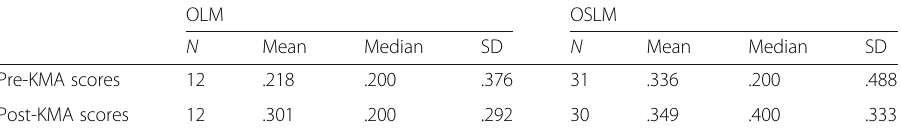
Table 7 KMA mean, median, and standard deviation scores for the OLM and OSLM groups OLM OSLM N Mean Median SD N Mean Median SD Pre-KMA scores 12 .218 .488 12 .301 .200